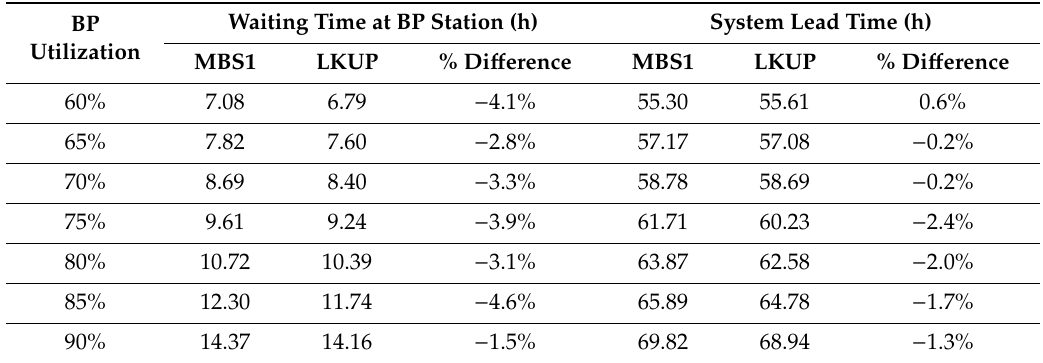
Table 2. Comparison of the Performance of LKUP (Look-Upstream) and MBS1 (Minimum Batch Size 1).